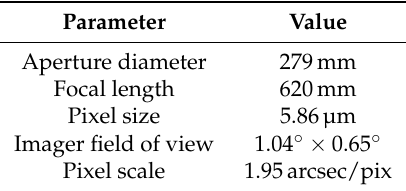
Table 2. OSCOM system specifications with the 11inch Rowe Ackermann Schmidt Astrograph telescope and Manta G-235